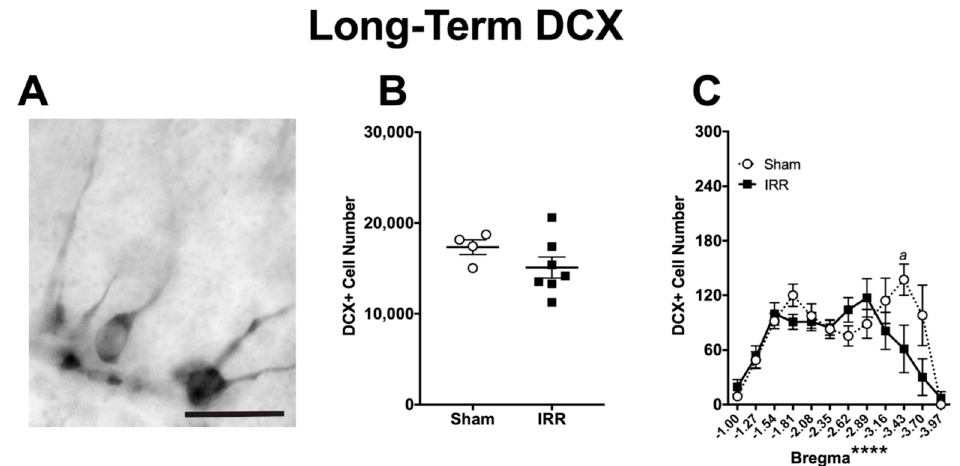
Figure 8. Three-mon post- 12 C irradiation, DCX+ cell number was similar between IRR and Sham mice. ( A ) Representative photomicrograph of DCX staining in a Long-Term Sham mouse (mouse #13851; 400 × , scale bar = 25 µ m). ( B ) An unpaired t -test revealed no difference in DCX+ cells between IRR and Sham mice ( p > 0.05; N = 4 Sham, N = 7 IRR). ( C ) Bregma analysis of DCX+ cells through two-way ANOVA (Bregma × Treatment) revealed a main effect of Bregma ( F 11,99 = 9.038; **** p < 0.0001), but not Treatment ( F 1,9 = 1.773; p > 0.05) and a significant interaction ( F 11,99 = 2.178; p < 0.05). Post-hoc (Sidak’s multiple comparison) revealed fewer DCX+ cells at bregma − 3.43 ( a p < 0.05). Error bars ± SEM.